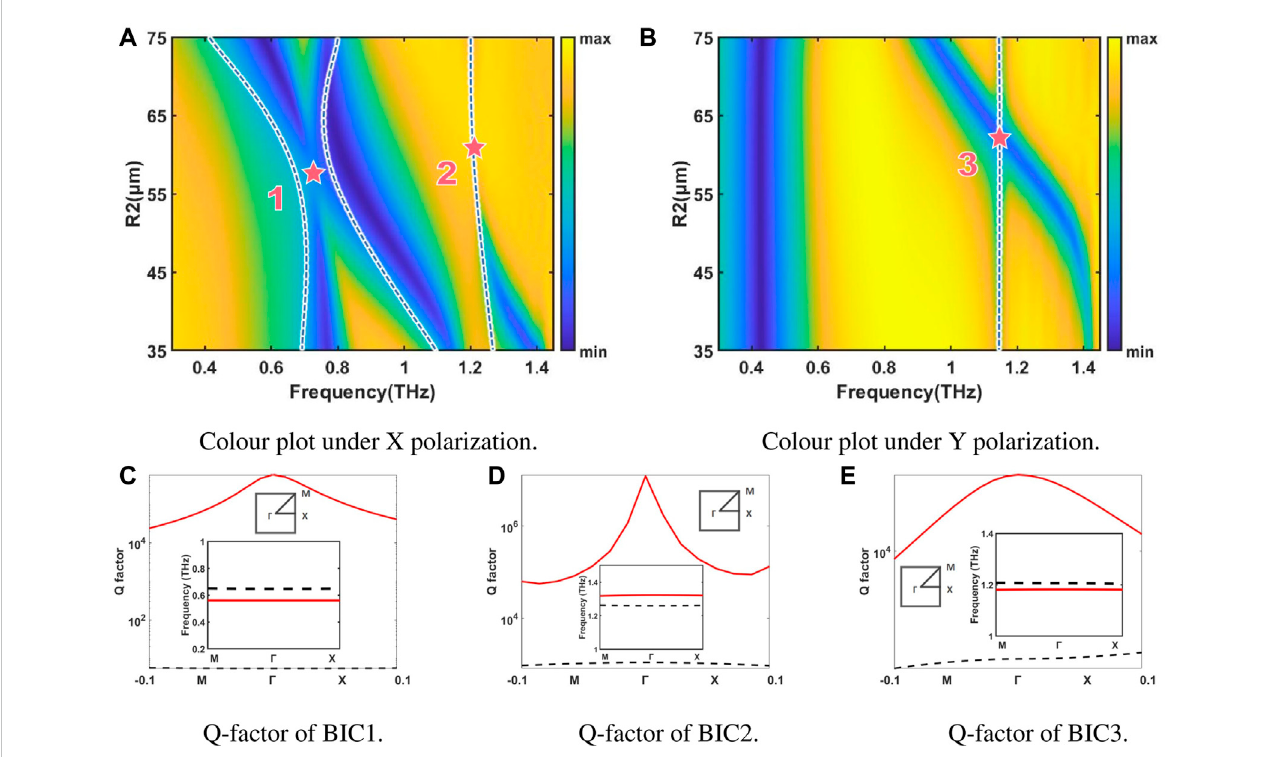
FIGURE 3 The numerical study of quasi-BIC caused by inter and outer double-ring resonance is shown. (A) Under the X-polarized incident wave, by scanning the inner ring radius from 35 um to 75 um, a color map of the simulated transmission spectrum of parameter-tuned BIC is drawn. (B) Under the Y-polarized incident wave, by scanning the inner ring radius from 35 um to 75 um, a color map of the simulated transmission spectrum of parameter-tuned BIC is drawn. (C) Corresponding to the fi rst BIC ’ s Q-factor and energy band structure (illustration). (D) Corresponding to the second BIC ’ s Q-factor and energy band structure (illustration). (E) Corresponding to the third BIC ’ s Q-factor and energy band structure (illustration). Reduction of metal loss, the imaginary part of dielectric constant ϵ reduced to 10e-6. The quasi-BIC we studied appears in the fi rst Brillouin zone Γ point, with an extremely high-Q